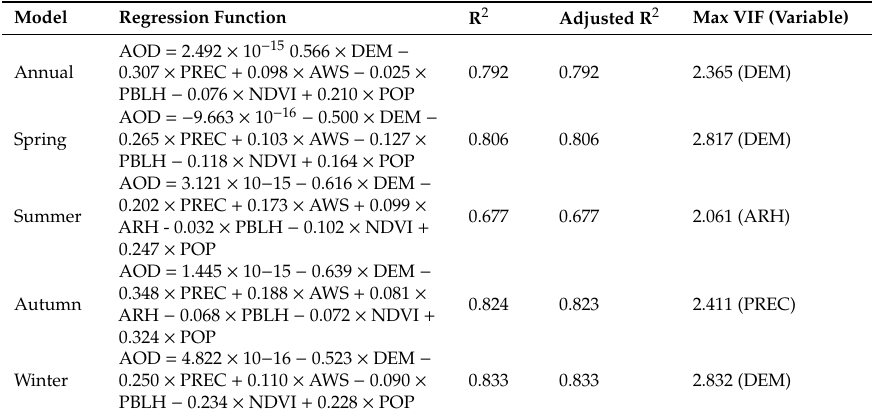
Table A5. Multiple linear regression analysis of season (annual) mean AOD and standardized impact